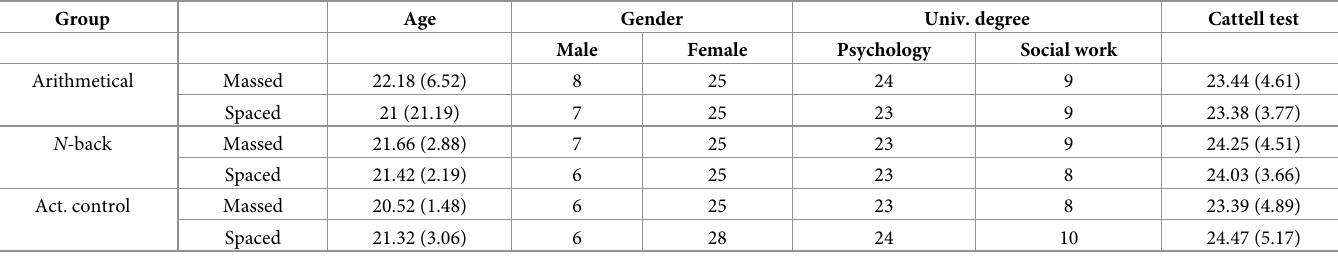
Table 2. Demographic details of the sample, by type of training or active control, and by practice distribution.